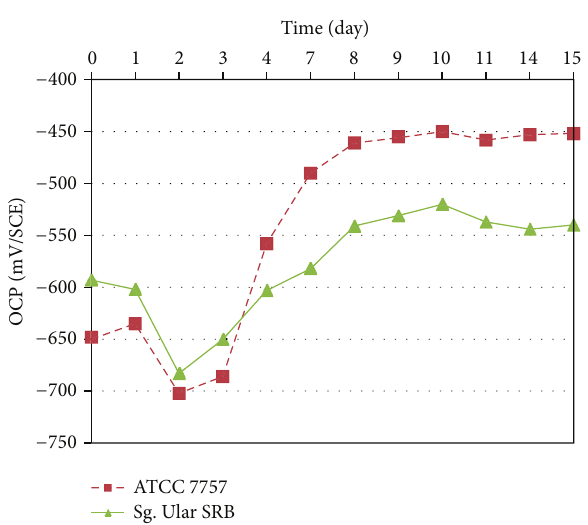
Figure 5: Plots of open circuit potential for carbon steel with SRB ATCC 7757 and Sg. Ular SRB.